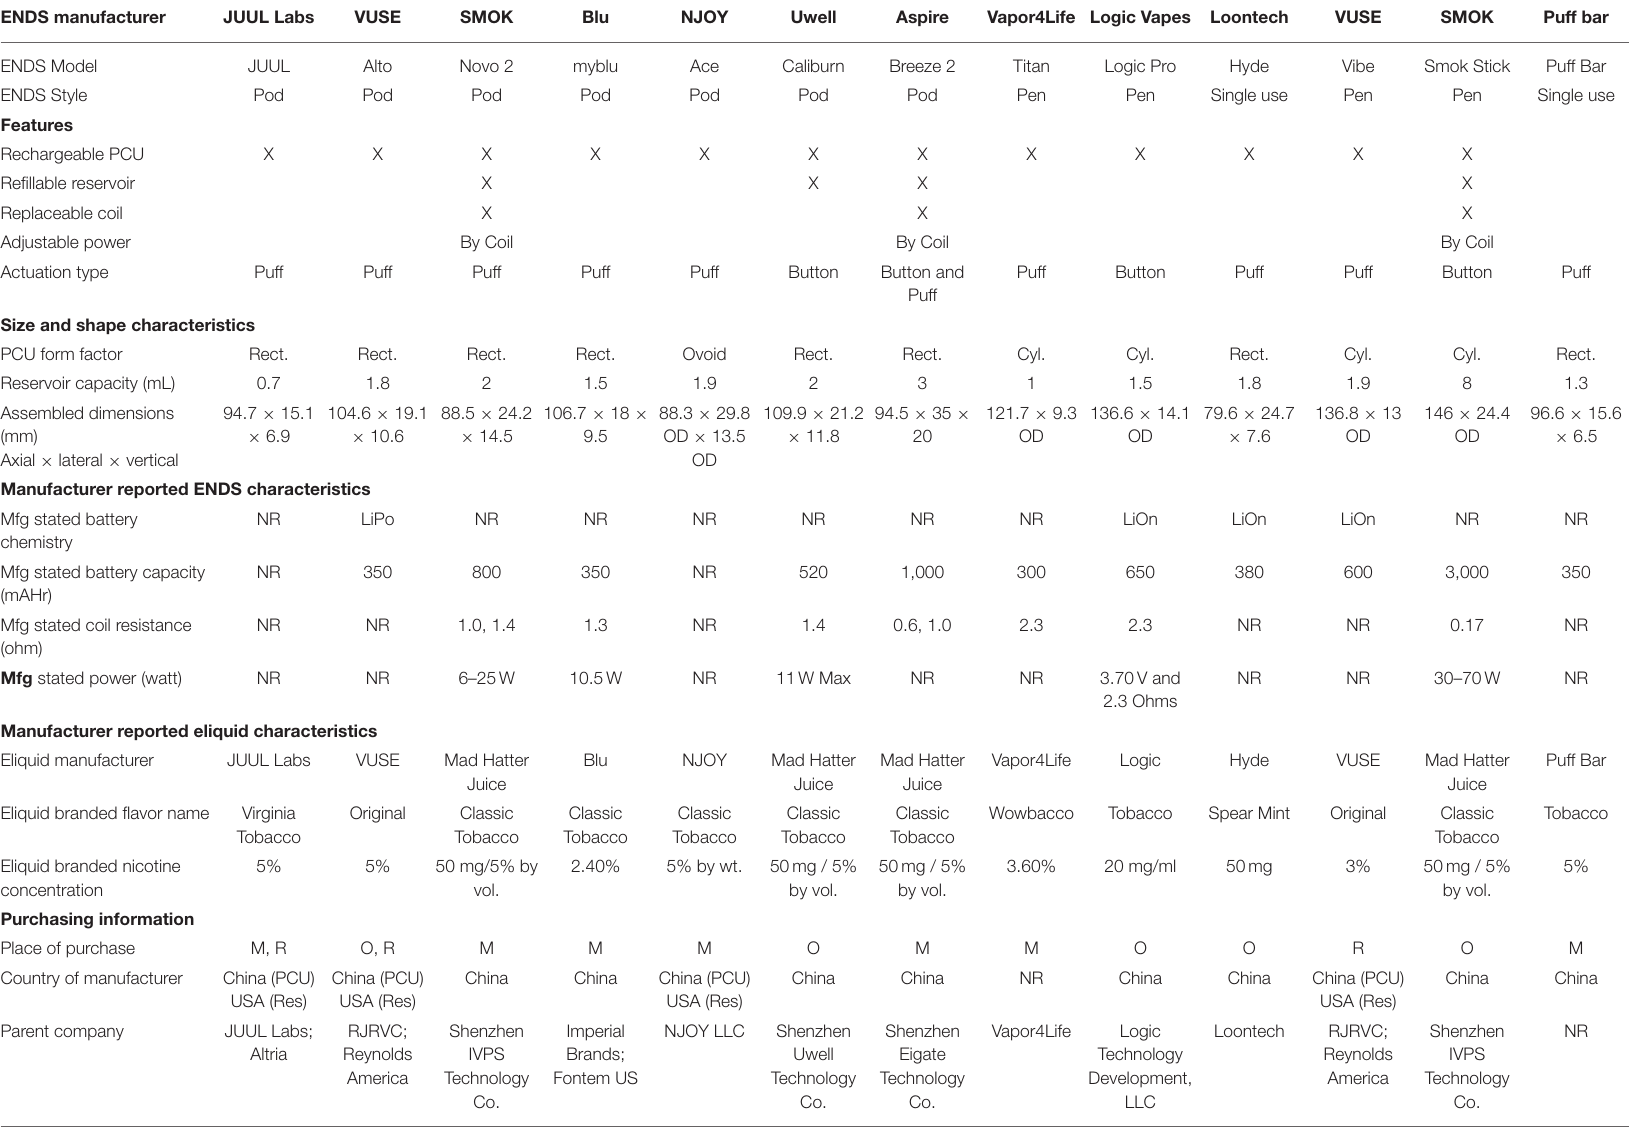
TABLE 1 | Test specimens used in screening trials for this